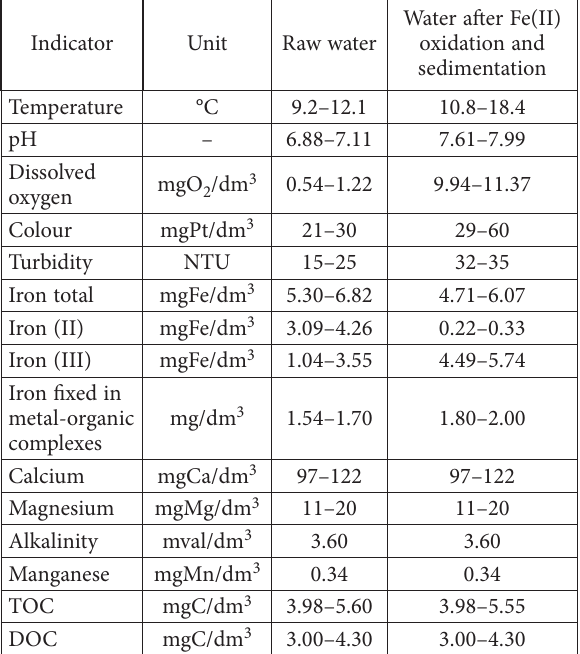
Table 2. Influence of filtration on the effectiveness of removing pollutants from groundwater after aeration and 2-hour sedimentation